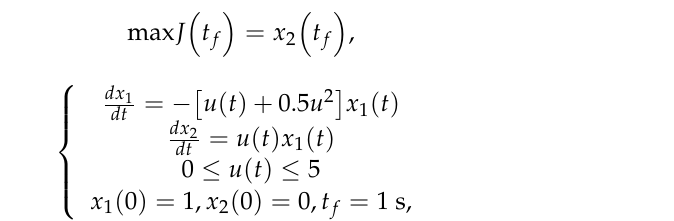
Figure 5. Optimal trajectory of state variables.